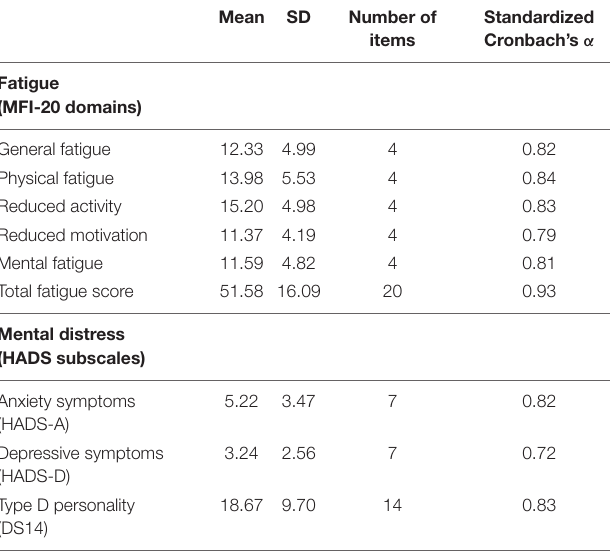
TABLE 1 | Internal consistency results for MFI-20, HADS, and DS14 ( N =